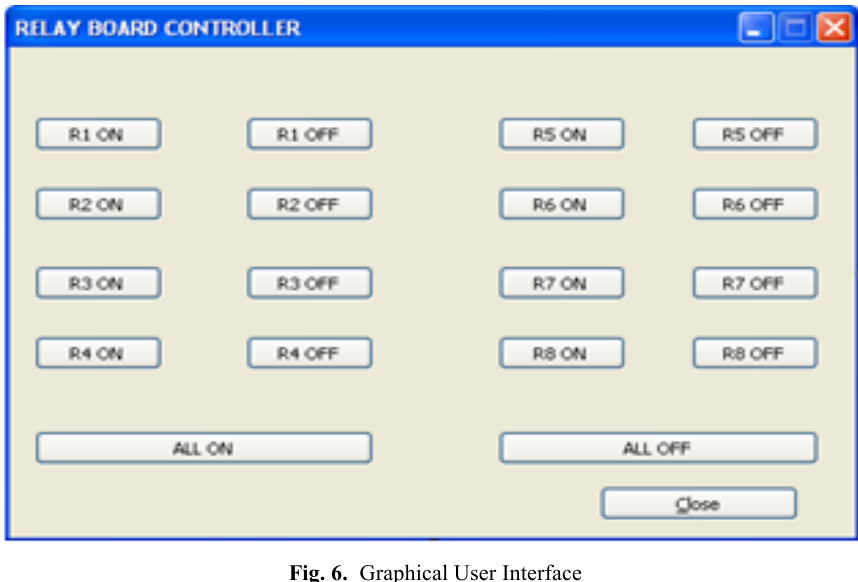
Fig. 6. Graphical User Interface